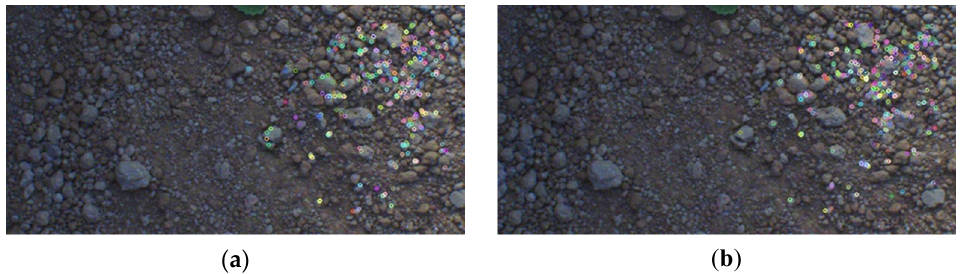
Figure 3. Feature points were detected in the inter-frame images. ( a ) Image feature points of the previous frame. ( b ) Image feature points of the next frame.